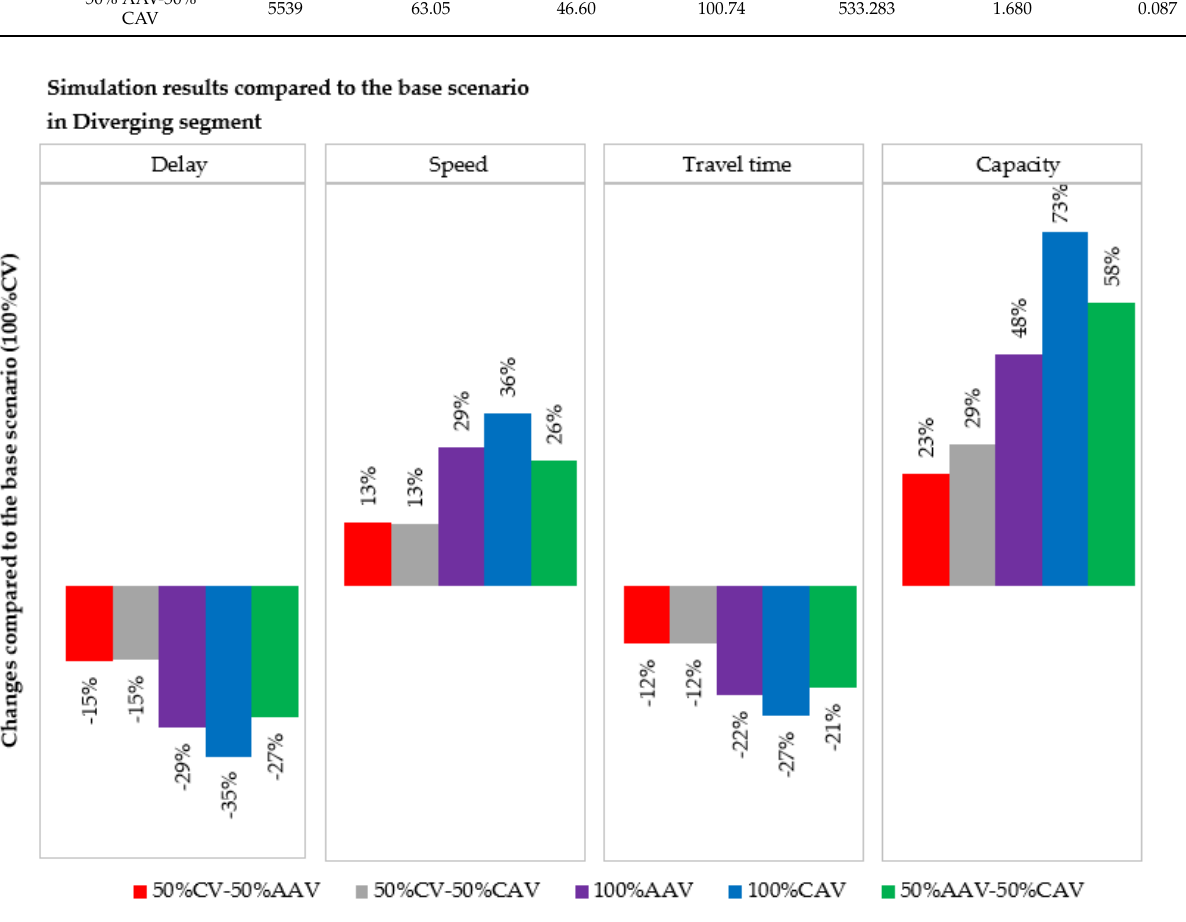
Figure 9. Simulation results traffic flow parameters compared to the base scenario (100% CV): diverging segment.